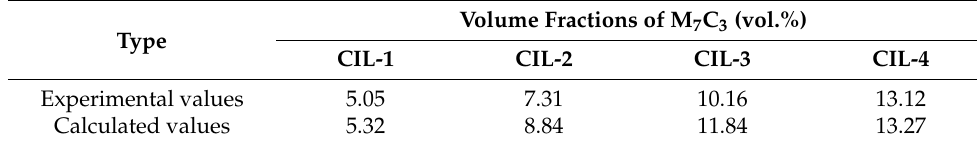
Table 2. Comparison of experimentally determined and calculated volume fractions of M 7 C 3.